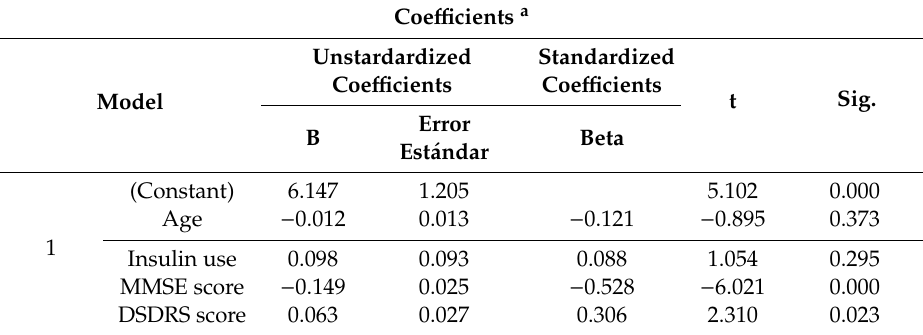
Table 3. Independent predictors of cognitive function (MCI and dementia).